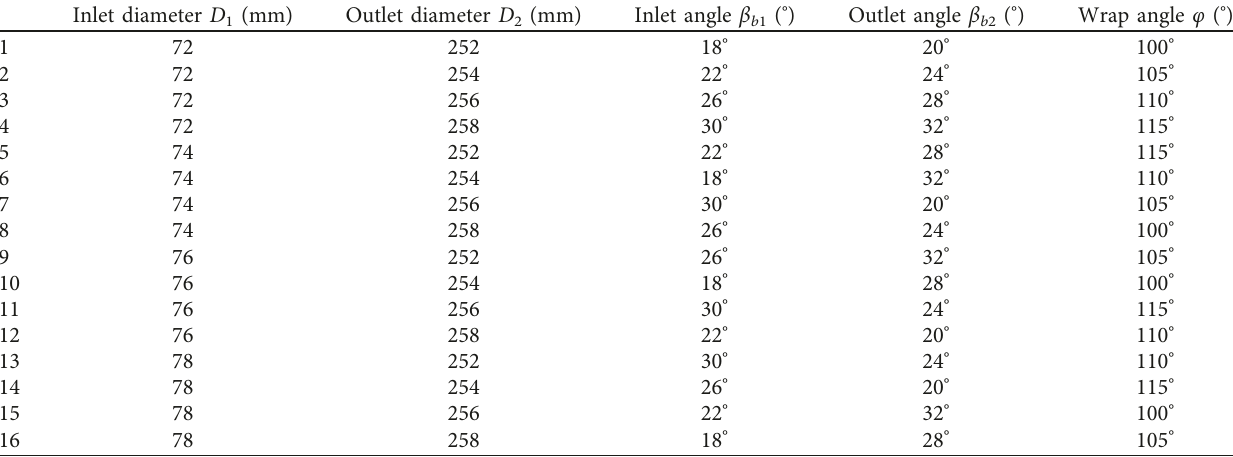
Table 12: Inner table of orthogonal experiment.